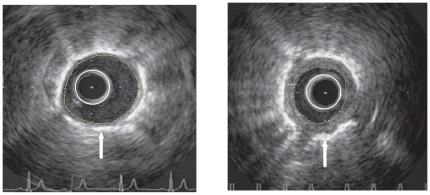
Representative images of an elastic PA with IVUS catheter in situ (white circle).Left image, IVUS image from a control subject with normal wall thickness, as shown by the area bounded by the luminal margin (yellow circle) and the bright elastic lamina (white arrow). Right image, IVUS image from a subject with severe PAH demonstrating a marked increase in wall thickness. Total vessel area was defined by the area circumscribed by the bright elastic lamina; wall area was defined as the total vessel area minus luminal area; and % wall thickness  =  wall area/total vessel area×100.